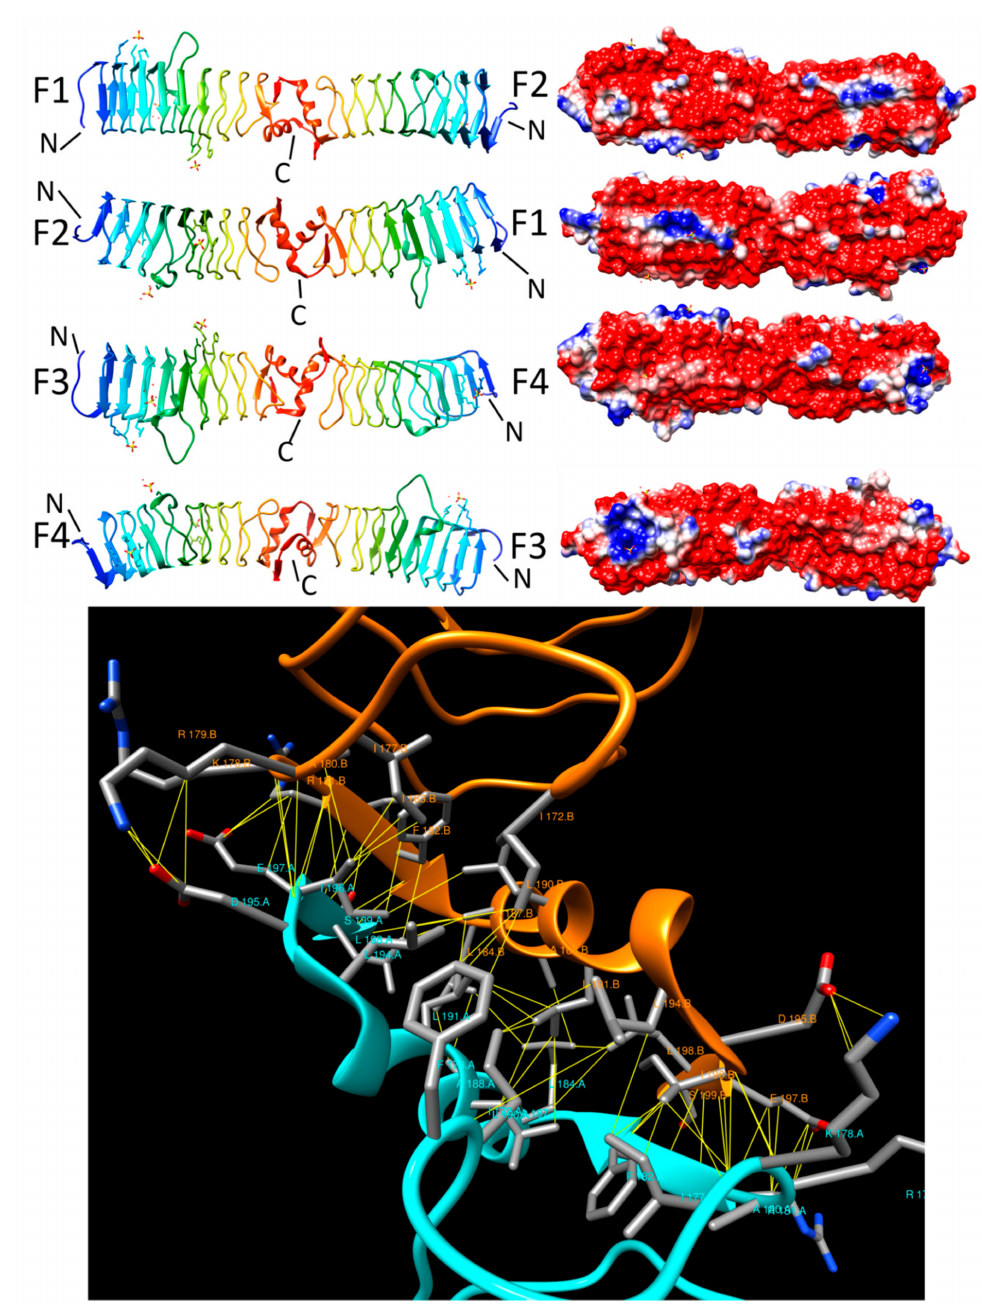
Figure 8. Structure and analysis of AlbG. The top panel shows the ribbon diagrams of the structure for four different orientations (at left) and the corresponding electronic potential surface plots (at right). The bottom panel is the interface model calculated by Intersurf and depicted using